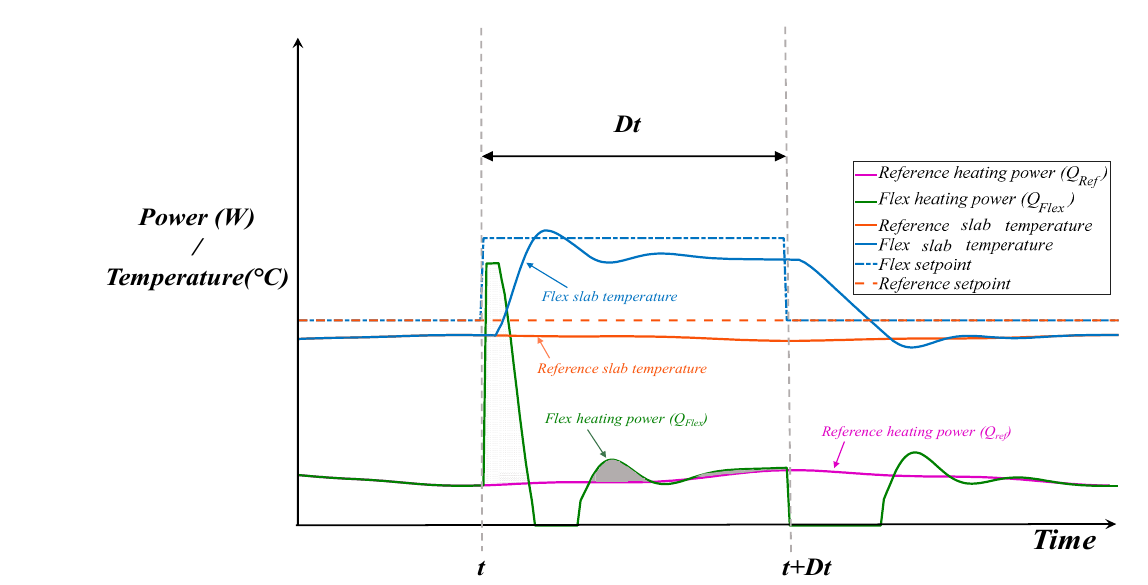
Figure 1. Schematic illustration of Building Energy Flexibility Index (BEFI).